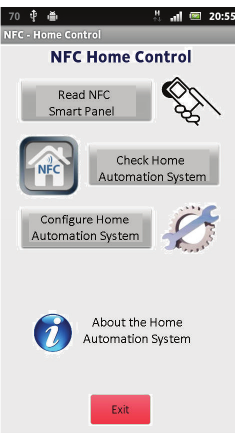
Figure 5: Graphical interface of the NFC-Home Control Android